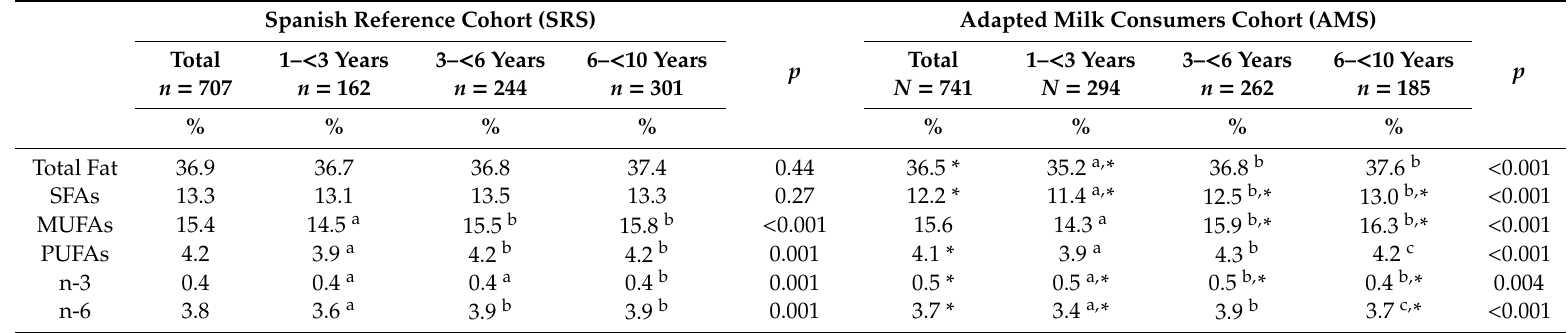
Table 4. Distribution of Individual Usual Intakes of total fat and main fatty acids as a percentage of the total energy intake (%EI) from two 24-h dietary recalls from the Nutritional Study in Spanish Pediatric Population (EsNuPI) according to age group ( n =